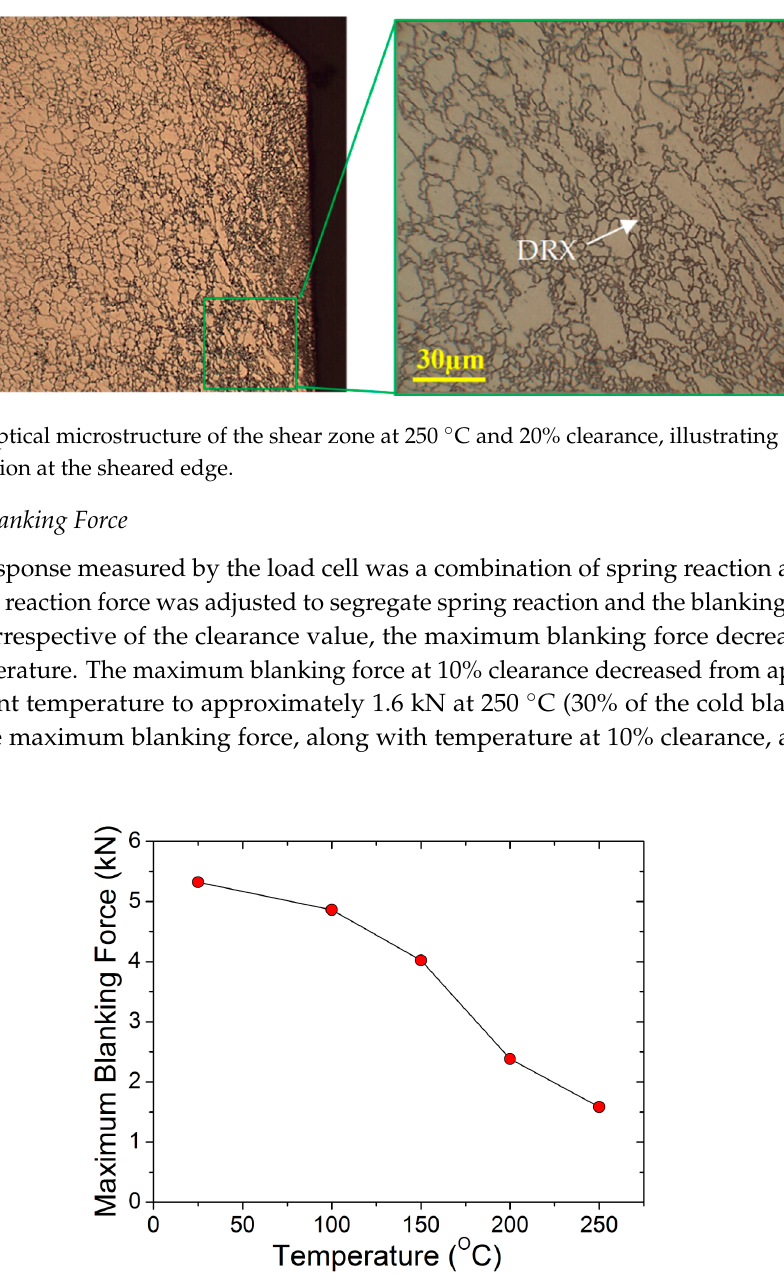
Figure 20. Optical microstructure of the shear zone at 150 °C and 20% clearance.